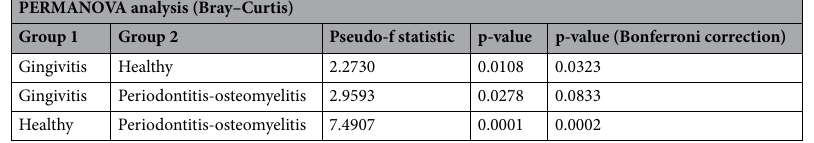
Table 2. Permutational multivariate analysis of variance (PERMANOVA) test using Bray–Curtis index showed significant differences in microbiota comparison of periodontitis-osteomyelitis group against healthy group as well as gingivitis against healthy group.